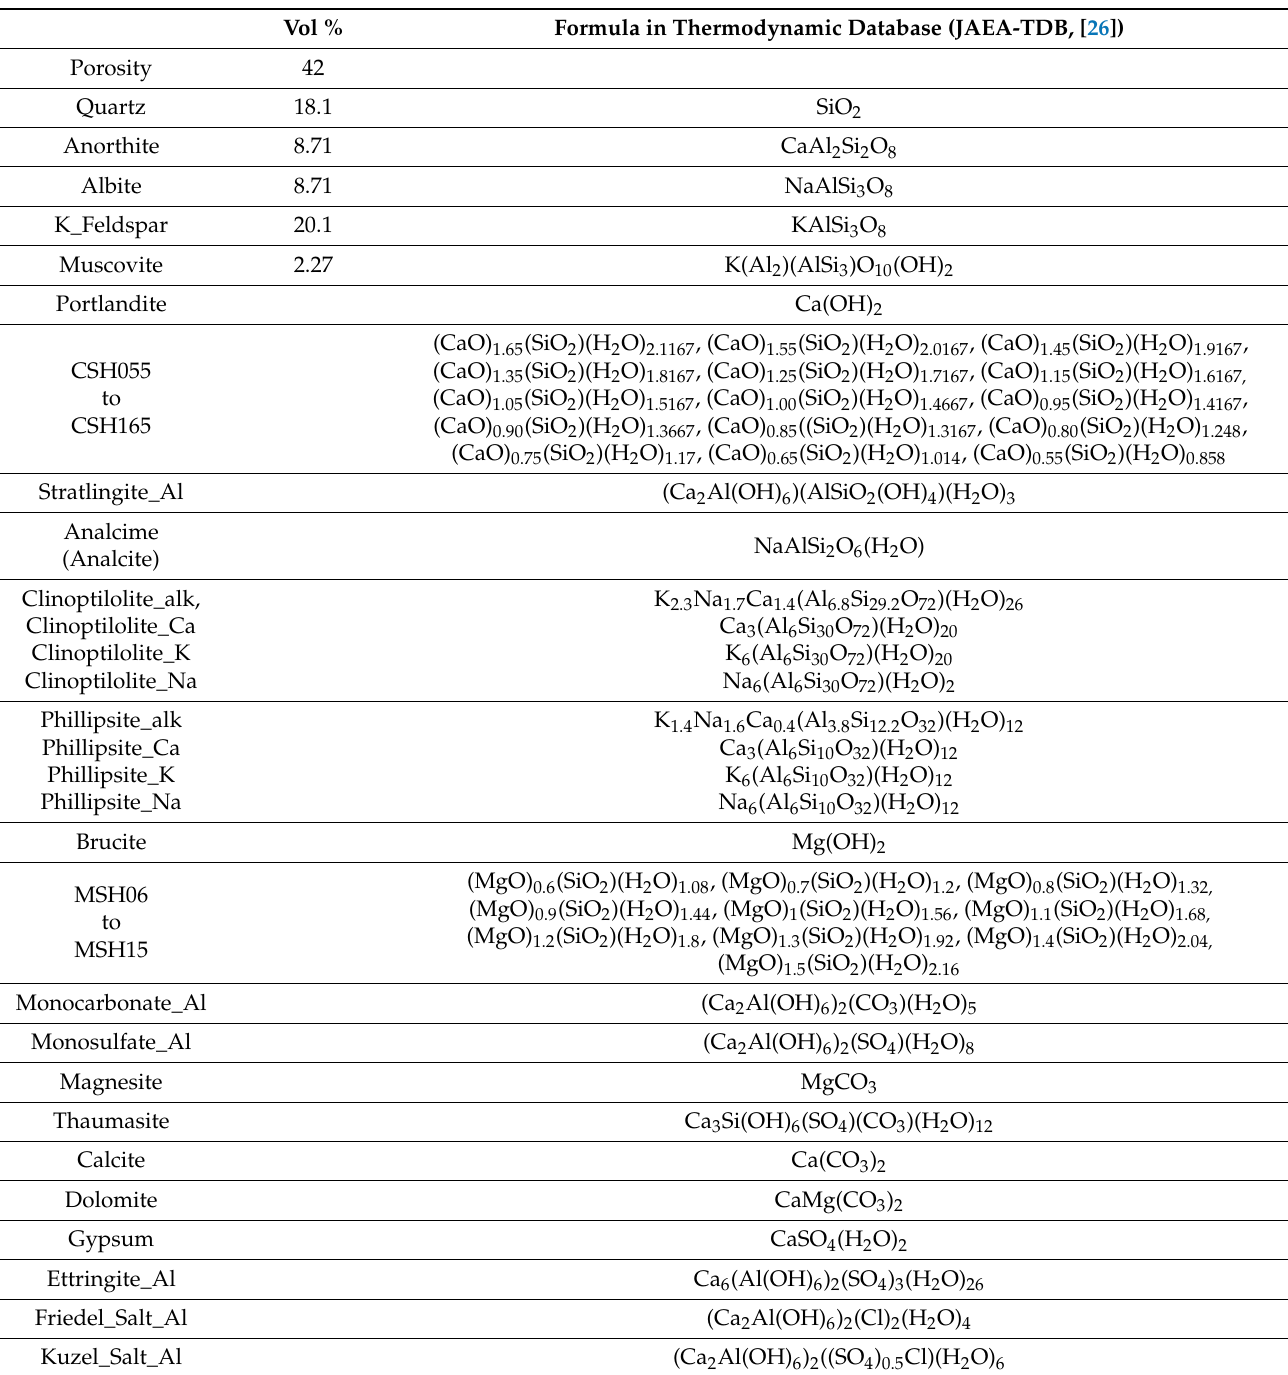
Table 2. Details of the ‘model’ Toki granite composition and potentially active